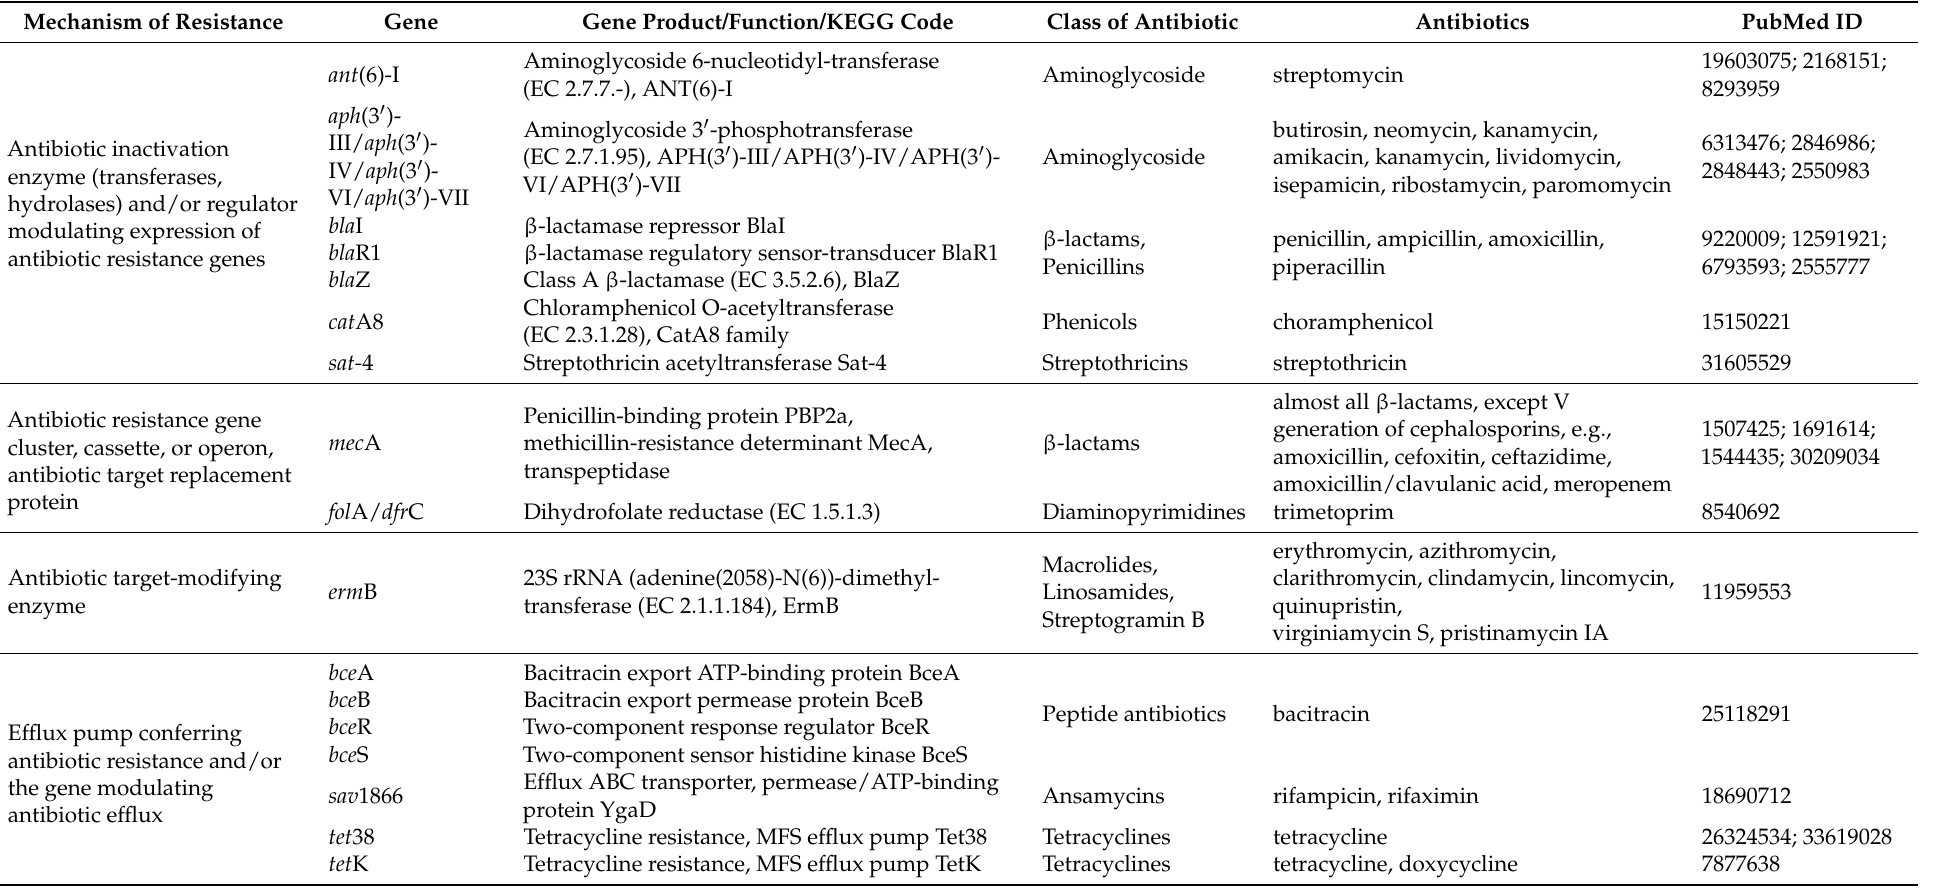
Table 5. Resistance genes and their regulatory regions, occurrence and expression correlate with the manifestation of the resistance phenotype. Mechanism of